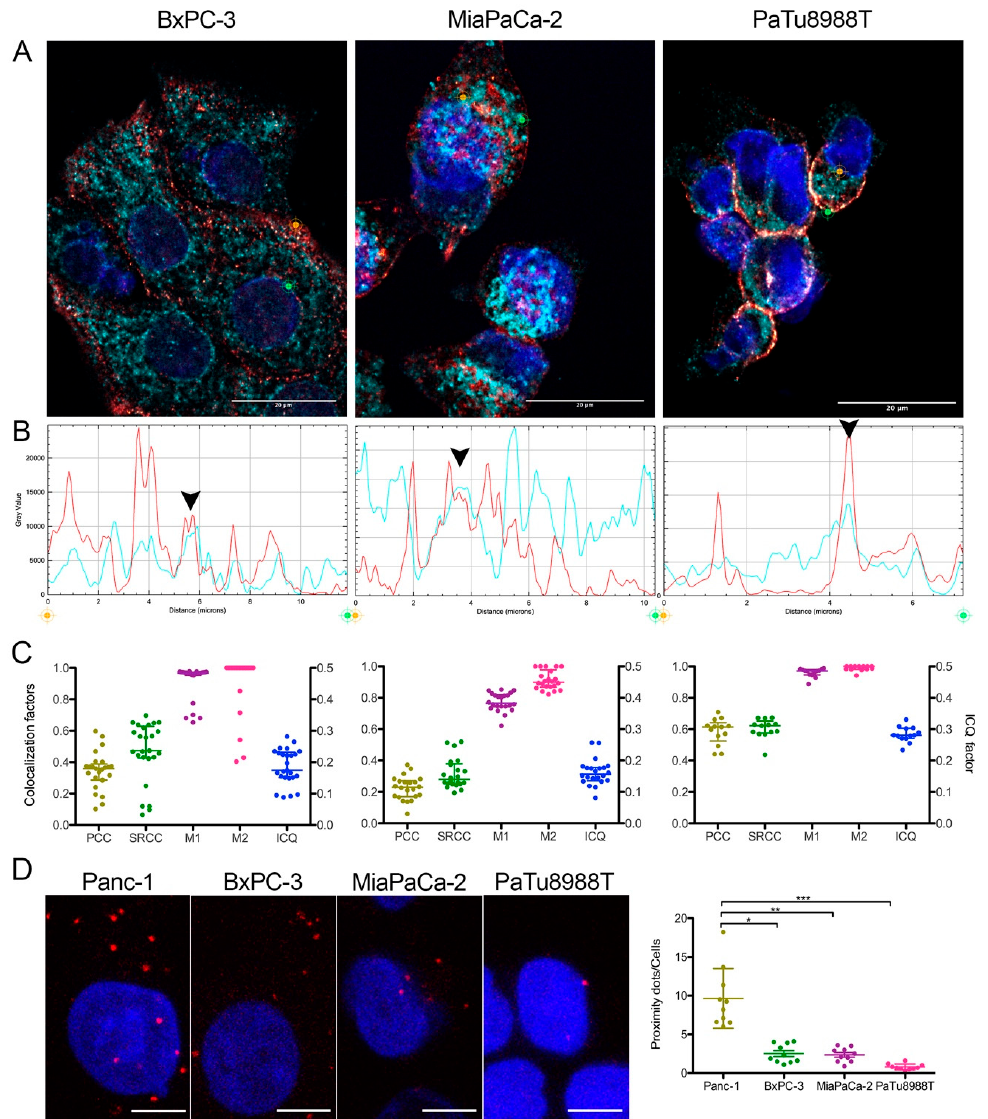
Figure 3. Myoferlin was colocalized with MFN1/2 in several pancreas cancer cell lines. ( A ) representative deconvoluted confocal image of nuclei (blue), myoferlin (HPA—“hot” red scale) and mitofusin-1/2 (3C9—“cold” cyan scale) immunofluorescence of BxPC-3, MiaPaCa-2 and PaTu8988T cell lines. Scale bar = 20 µm. ( B ) Channel intensity profiles were established following the segment between orange and green cross marks. Black arrow heads indicate colocalization spots. ( C ) Pearson (PCC), Spearman rank (SRCC) correlation coefficients, Manders’ colocalization coefficients (M1,M2), and intensity correlation quotient (ICQ) were calculated on >13 independent microscopic fields. ( D ) Representatives images of MFN1/2-MYOF proximity ligation assay (PLA). Scale bar = 4 µm. MFN1/2-MYOF PLA ( N = 10) were quantified using ImageJ. Kruskal–Wallis non-parametric test followed by Dunn’s a pairwise comparison was performed, * p < 0.05, ** p < 0.01, *** p < 0.001. All experiments were performed as three independent biological replicates.